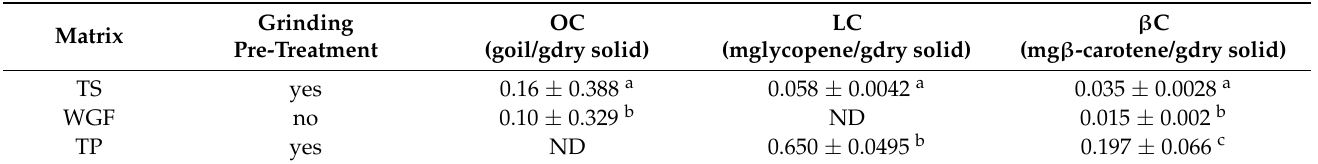
Table 2. Oil Content (OC), lycopene content (LC), and β -carotene content ( β C) in tomato seeds